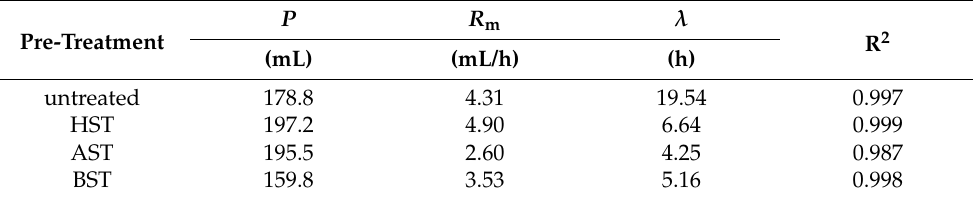
Table 8. Correlation analysis between hydrogen, butyrate and acetate. Correlation Pre-Treatment (Hydrogen-Acetate) Untreated